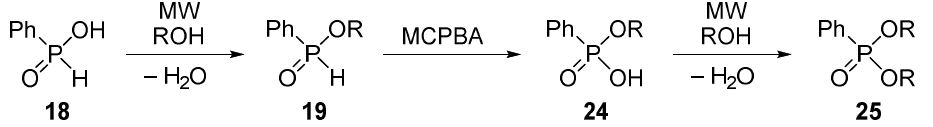
Molecules 2021 , 26 , x FOR PEER REVIEW